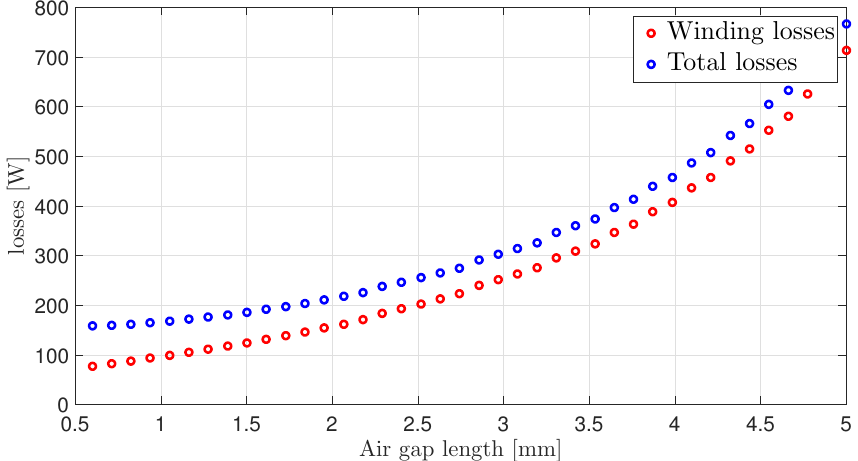
Figure 6. The winding and the total losses variation with the air gap length.